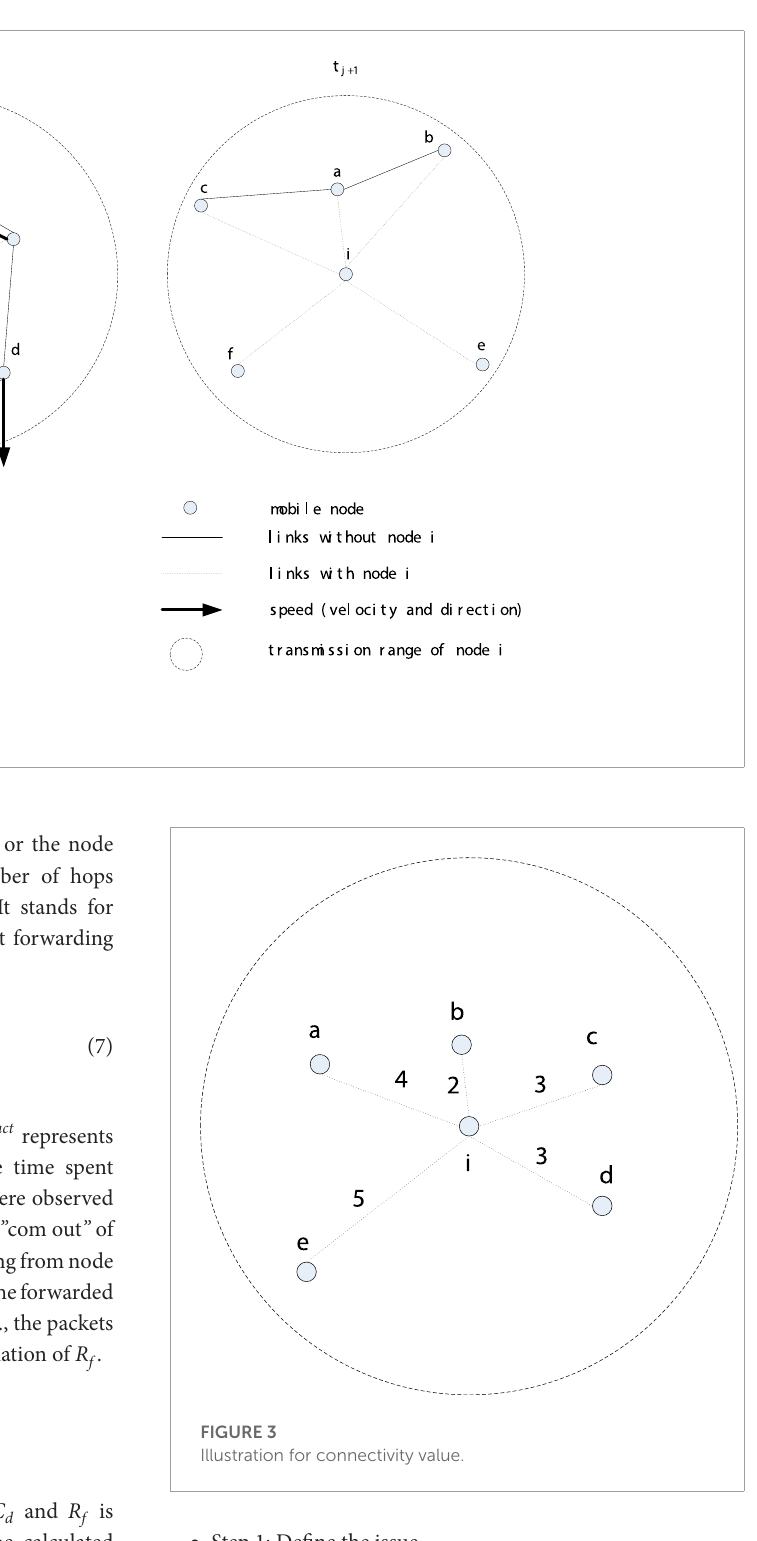
FIGURE 3 Illustration for connectivity